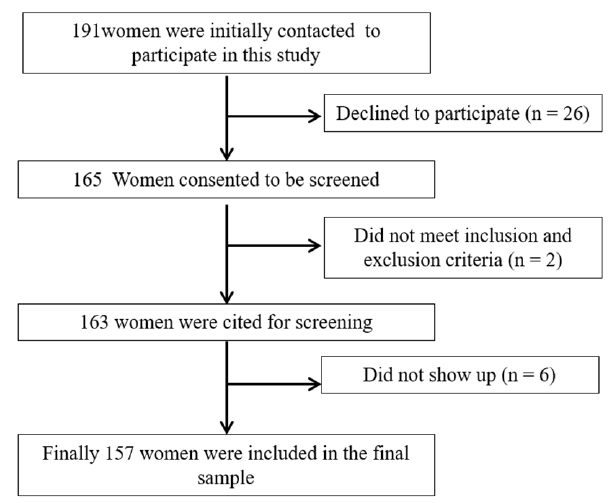
Figure 1. Flowchart diagram of the participants in this study.